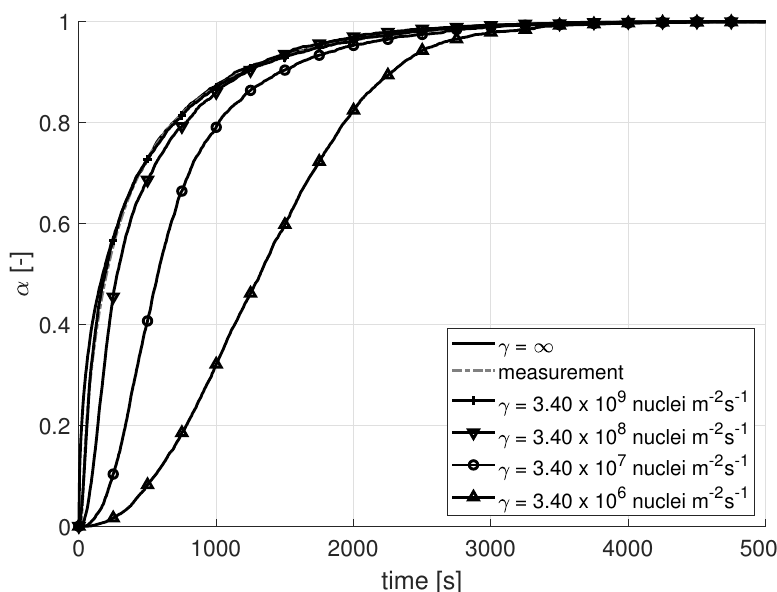
Figure 13. Isotropic diffusion-limited model. The effect of the nucleation rate shown by increasing γ from γ = 3.40 × 10 6 nuclei m − 2 s − 1 to γ = 3.40 × 10 9 nuclei m − 2 s − 1 ( D = 9.80 × 10 − 14 m 2 s − 1 ). For γ = ∞ , the optimized diffusion coefficient becomes D = 7.18 × 10 − 14 m 2 s − 1 . At γ = ∞ , all the surface points of the particles are nucleated